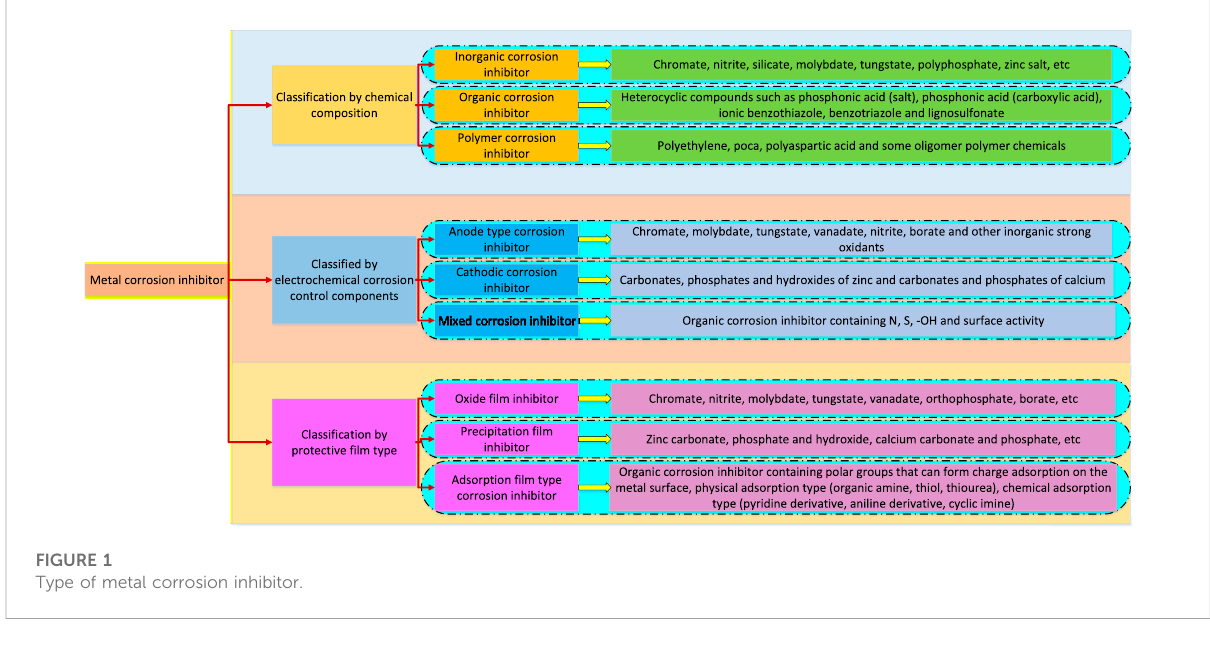
FIGURE 1 Type of metal corrosion inhibitor.